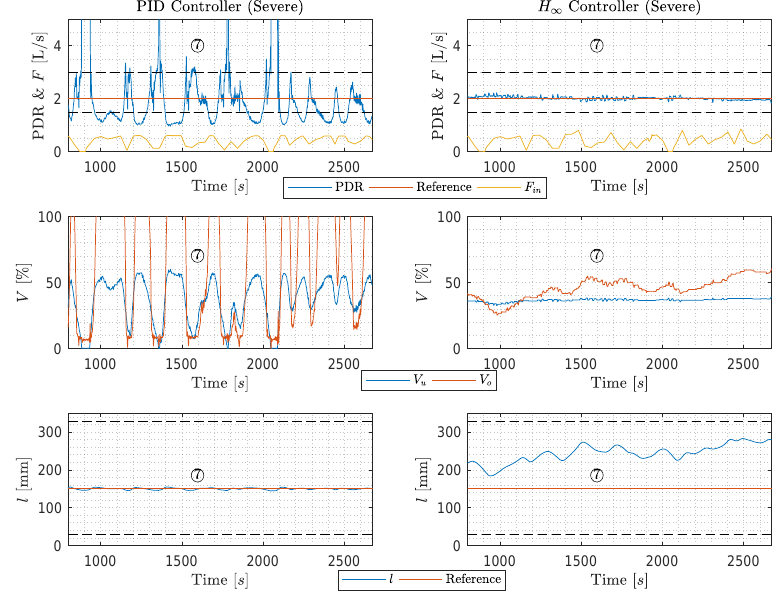
Figure 9. Test results for severe operation 7 (cid:13) , where F in is fluctuating in the range 0–0.8